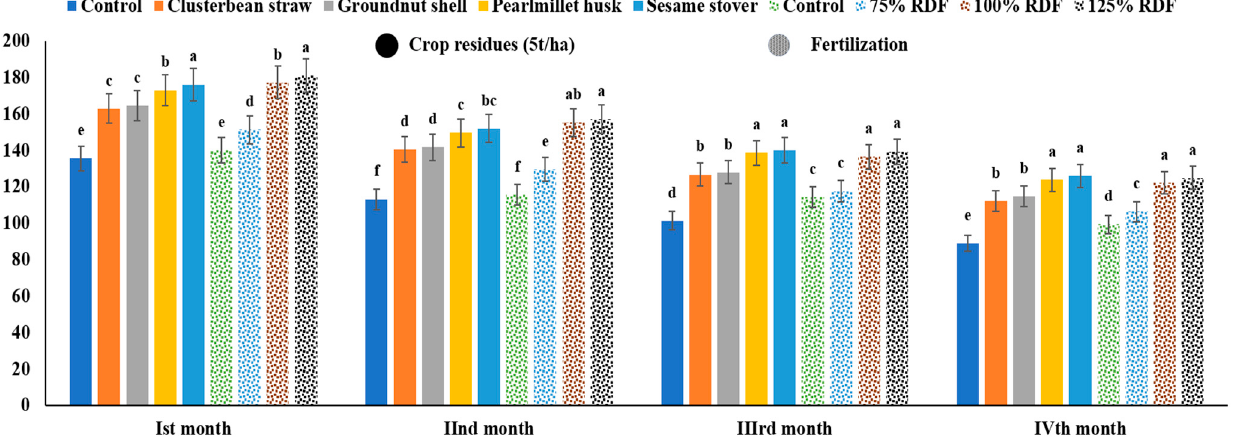
Figure 1. Effect of crop residues and fertilization on microbial biomass carbon (µg g − 1 ) at first, second, third, and fourth month after sowing. In this figure, the values followed by different lowercase letters indicate no significant difference ( p > 0.05) by Duncan’s multiple range test (DMRT).